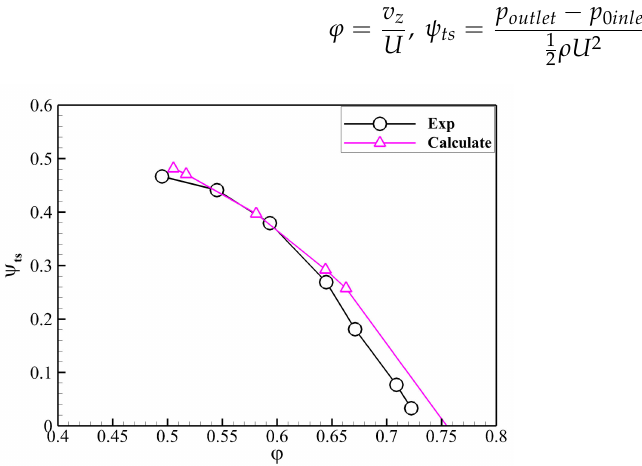
Figure 4. Steady-state characteristics of a single-stage